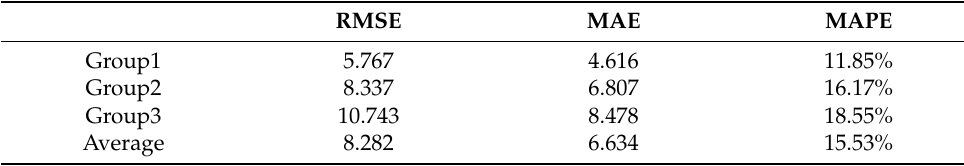
Table 4. GBDT Fitting degree under a training set.